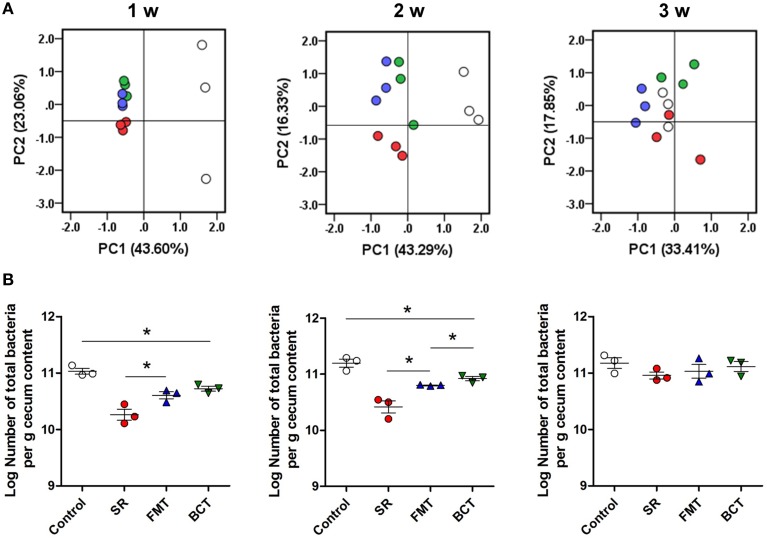
The recovery of intestinal microbiota in different mice groups. (A) PCA of the cecal microbiota in different experimental mice groups during the 3-week recovery. PC1 and PC2 account for 66.66, 59.62, and 51.26% of the variation in different weeks. Each symbol represents one microbiota (dot). White dots, healthy mice; red dots; SR mice, blue dots, FMT mice; green dots, BCT mice. (B) The population of total intestinal microbes in different mice groups detected by qPCR. *p < 0.05; w, week(s) after ceftriaxone treatment.